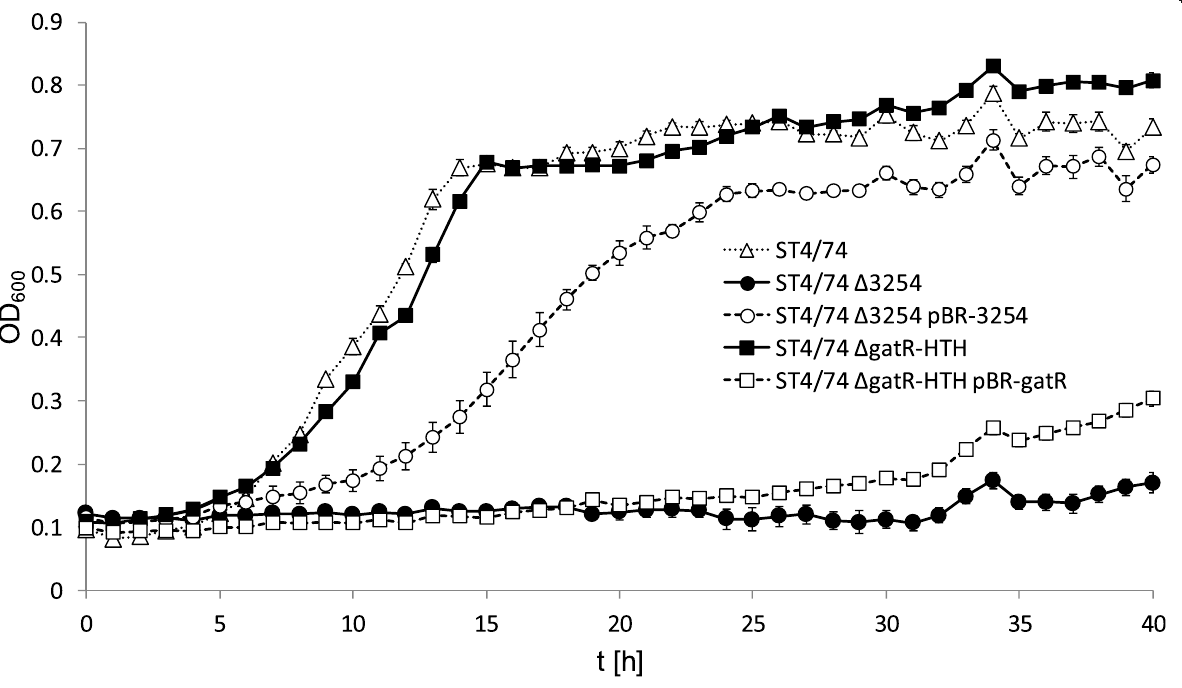
Fig. 5 Tagatose-dependent growth phenotypes of S . Typhimurium. Growth curves of strains ST4/74, ST4/74 Δ STM3254, ST4/74 Δ STM3254/pBR-3254, ST4/74 Δ gatR -HTH, and ST4/74 Δ gatR -HTH/pBR- gatR in MM with 1% D-tagatose as sole carbon source. Standard deviations of three replicates are shown